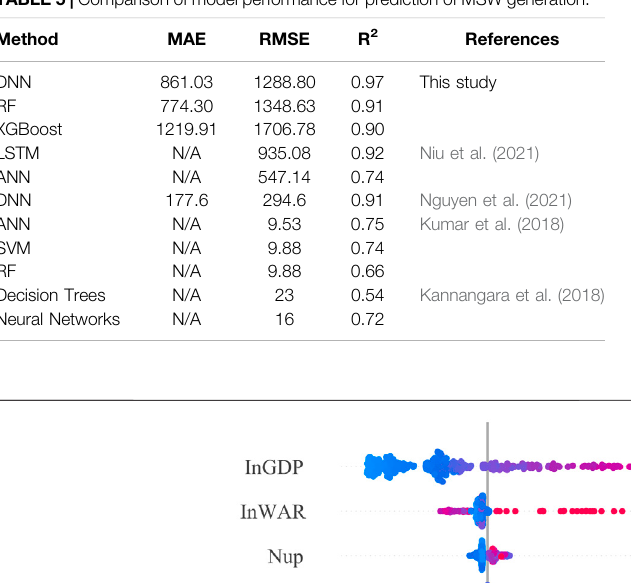
TABLE 5 | Comparison of model performance for prediction of MSW generation.